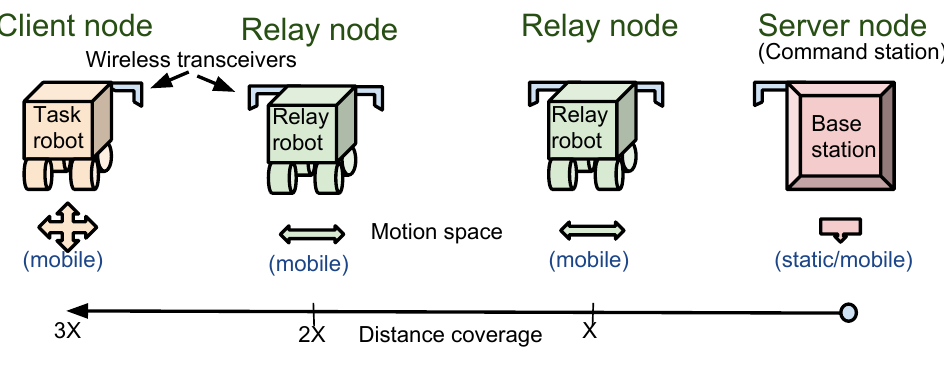
Figure 1. Server-relay-client (SRC) architectural view of this study.